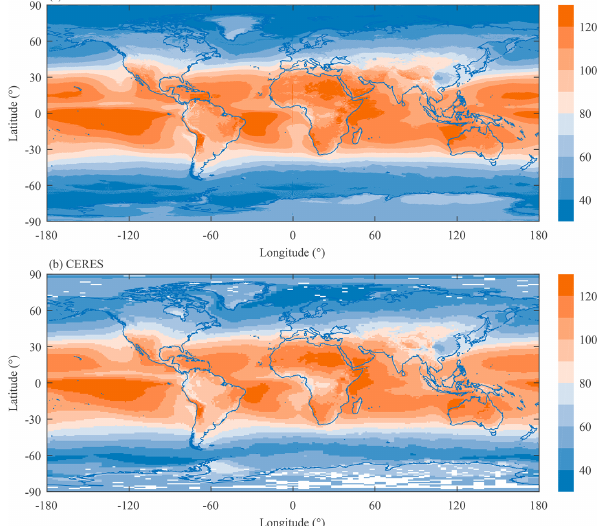
Figure 10. Spatial distribution of annual mean PAR between 2001 and 2018, derived from (a) our estimated PAR product (ISCCP- ITP), and (b) the CERES PAR product. The unit of PAR is Wm − 2